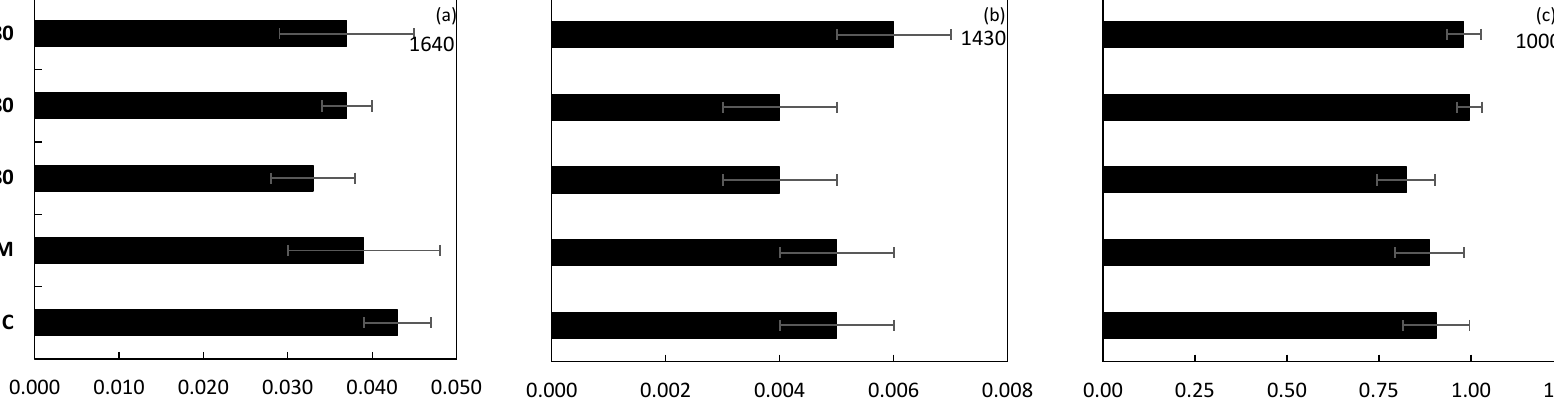
Figure 7. Mean (n = 3) relative absorbance intensities of ( a ) 1640 cm − 1 ( b ) 1430 cm − 1 and ( c ) 1000 cm − 1 ATR-FTIR bands identified for rainforest soils after harvest. C = control, M = manure treatment, M80 = Manure + 80 kg N/ha, O80 = No manure + 80 kg N/ha S80 = soil pot with 80 kg N/ha without any vegetables.